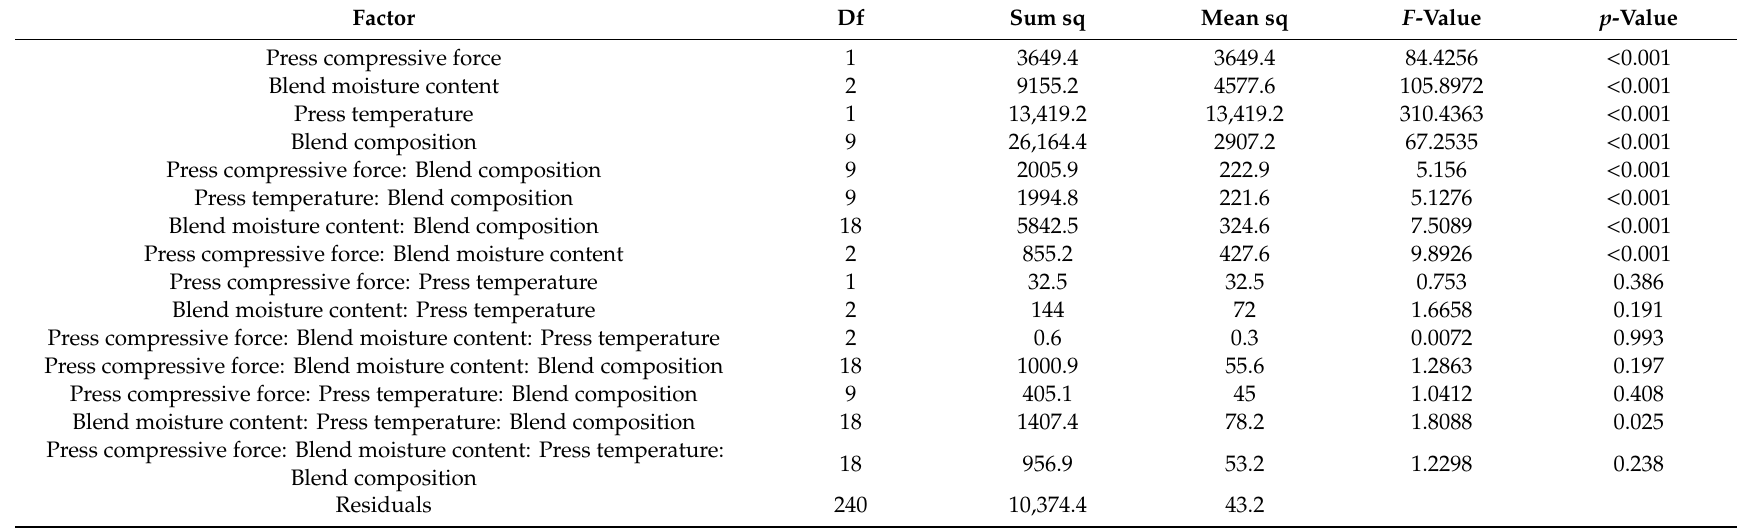
Table 5. Parameters and p -values from ANOVAs testing the e ff ects of blend composition, moisture content, press compressive force, and temperature on